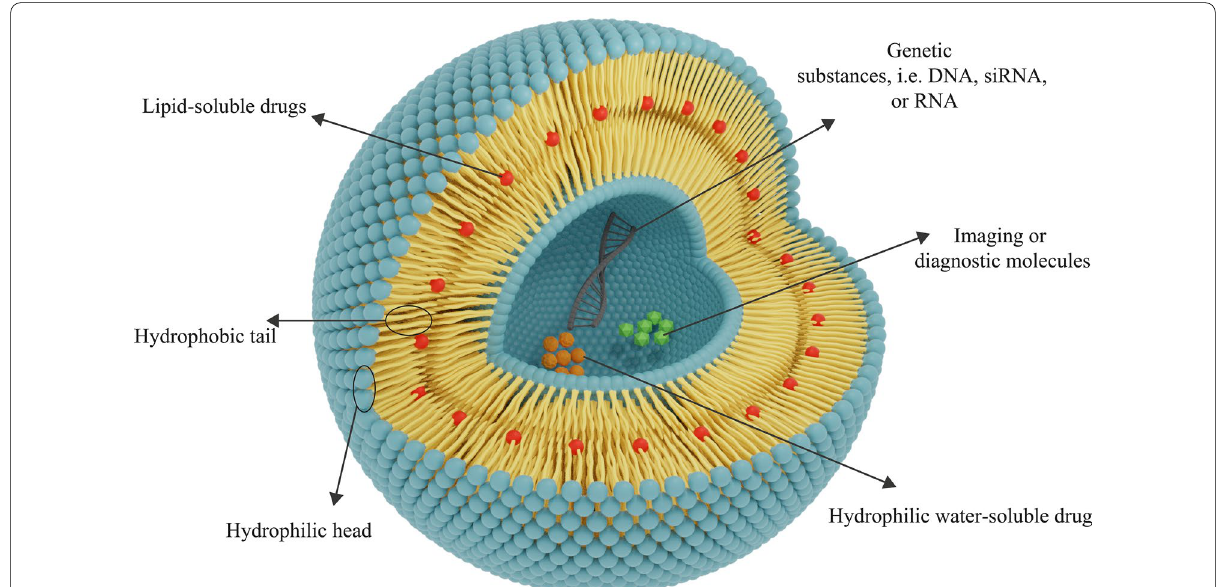
Fig. 4 The general structure of the liposomes consists of phospholipid layers. Depending on the hydrophilicity–hydrophobicity of a drug, the appropriate kind of liposomes for its delivery will be determined. Hydrophilic drugs are entrapped in the central hydrophilic nucleus, and hydrophobic drugs are placed in the lipophilic area. Liposomes can also be utilized for the delivery of